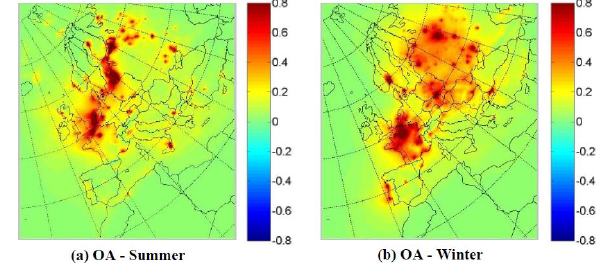
Fig. 9. Predicted reduction (base case – emissions reduction sce- Figure 9. Predicted reduction (base case - emissions reduction scenario) in ground-level 3 nario) in ground-level concentrations (µgm − 3 ) of total PM 2 . 5 after concentrations (μg m -3 ) of total PM 2.5 after a 50% reduction of anthropogenic POA emissions 4 a 50% reduction of anthropogenic POA emissions during (a) the during (a) the modeled summer period and (b) the modeled winter period. A positive value 5 modeled summer period and (b) the modeled winter period. A pos- corresponds to a decrease. 6 itive value corresponds to a decrease.